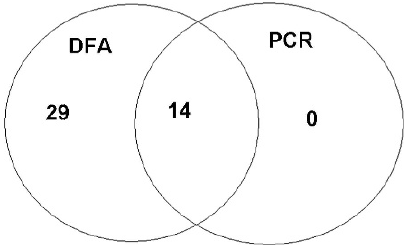
Figure 1 - Venn diagram from group A (43 DFA-positive results).